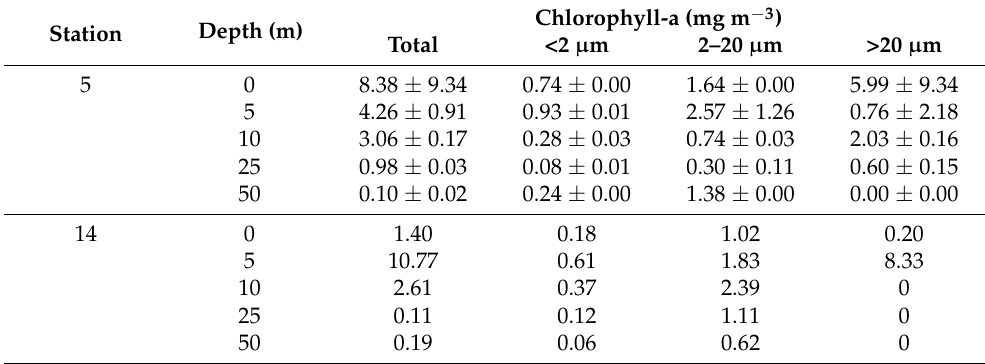
Table 1. Fractionated chlorophyll-a concentrations (mg m − 3 ) in marine station 5 and estuarine station